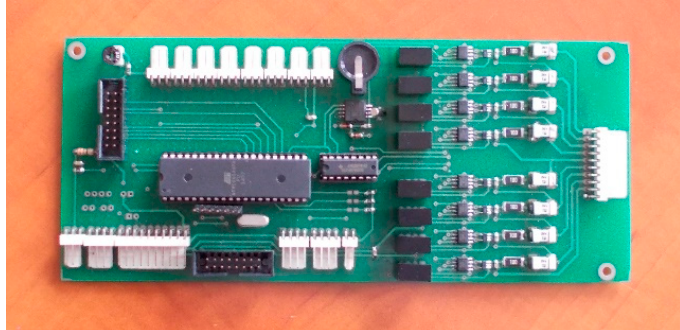
Figure 7. Block diagram of the cell measurement system for the battery with connected BMS with active balancing, the cell-to-battery method.